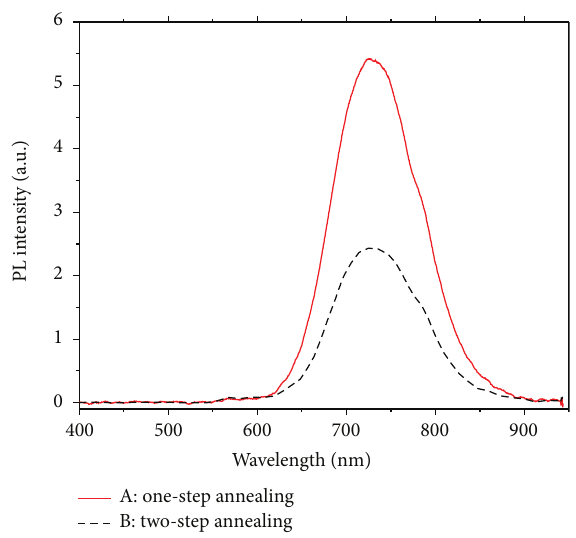
Figure 2: PL emission from Si-NCs embedded in silica matrix and prepared by two methods as described above: A (red curve) and B (black dashed curve).